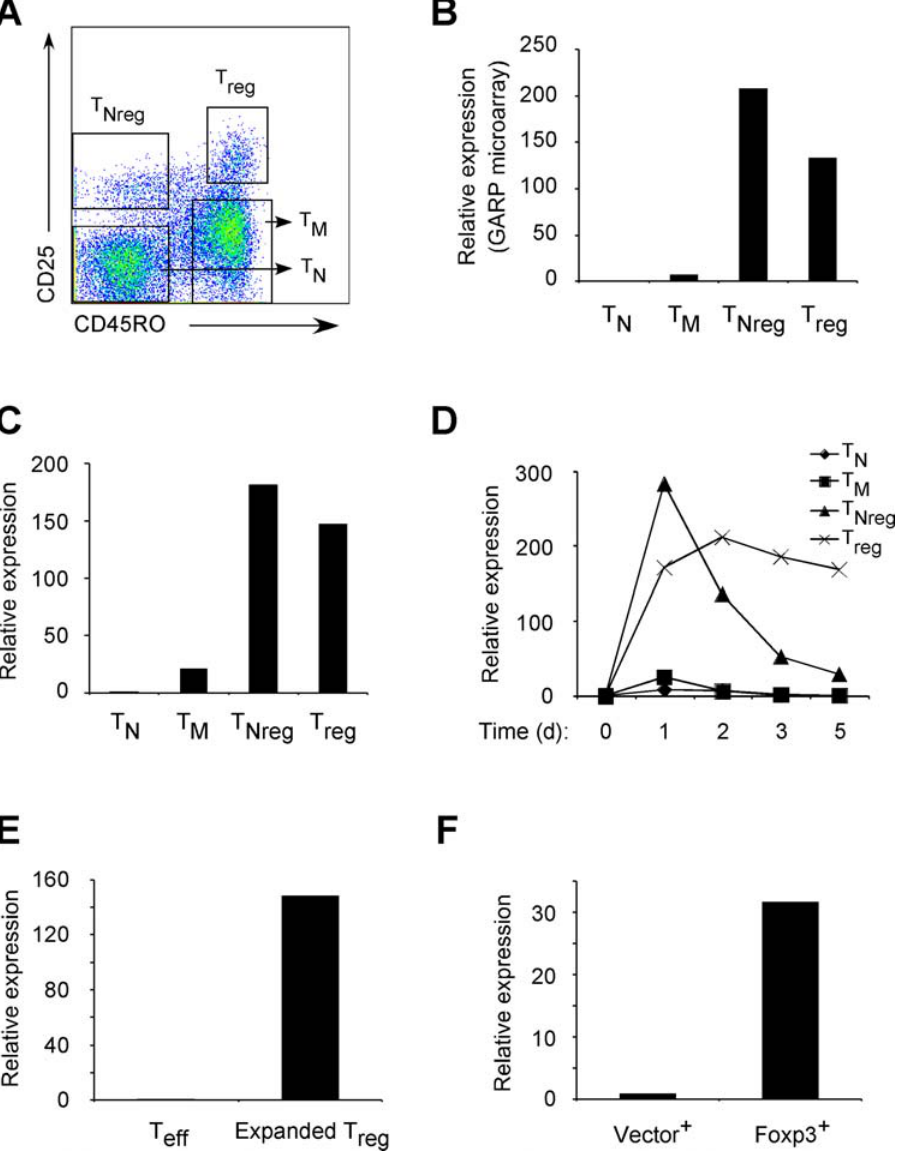
Figure 1. GARP is specifically expressed in activated T reg cells. ( A ) Representative T cell subset staining from normal donor. CD4 + T cells isolated from human PBMC were stained with anti-CD25 and CD45RO antibodies. Naı¨ve (T N ), memory (T M ), T Nreg and T reg cells were identified as shown in brackets. ( B ) GARP levels of recently activated T cell subsets from the microarray. ( C ) GARP levels of different T cell subsets 1 day post TCR activation as determined by qPCR. One representative experiment of five donors is shown. ( D ) Kinetics of GARP levels in different T cell subsets at different time points before and after TCR stimulation. Diamond, T N ; square, T M ; triangle, T Nreg ; cross, T reg . d, day. One experiment representative of three donors is shown. ( E ) Expanded T reg cells from T Nreg precursors and ( F ) Foxp3-transduced cells upregulate GARP after TCR stimulation. Cells were in vitro expanded for two weeks before subjecting to qPCR analysis. T eff , expanded T N cells; Vector + , control vector-transduced T N cells; Foxp3 + , Foxp3-transduced T N cells. One experiment representative of three donors is shown.